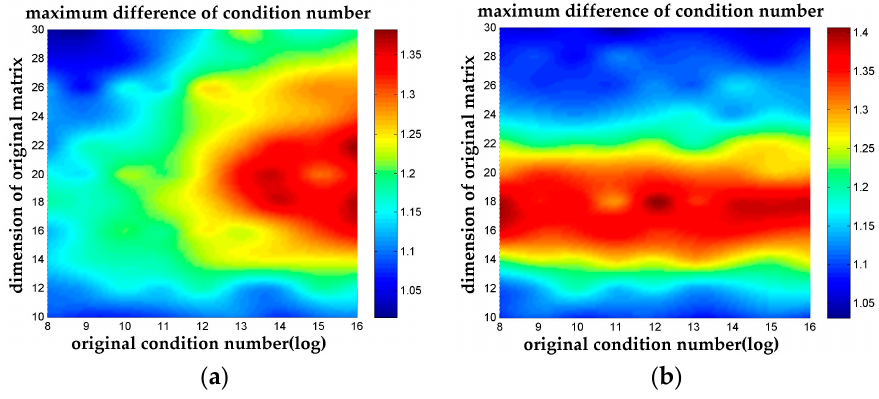
Figure 5. The maximum difference of condition numbers. The max value of the difference of condition number between n -LLL and LLL among all possible n parameter is plotted in the thermodynamic diagram. ( a ) The maximum difference of condition numbers for Case 1; ( b ) The maximum difference of condition numbers for Case